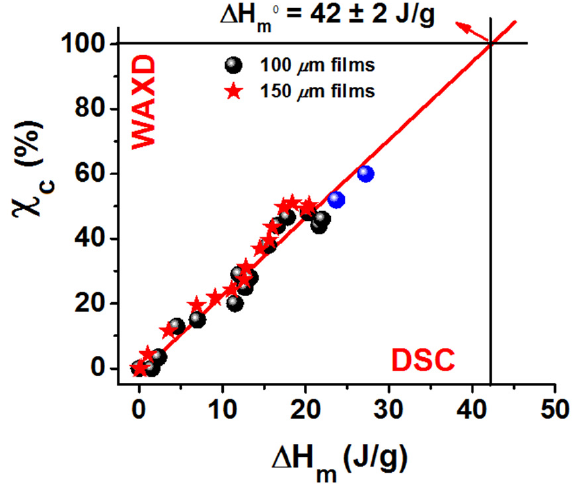
Figure 7. Crystallinity index ( χ c , from WAXD patterns) and melting enthalpy ( ∆ H m , from DSC scans) of NC α form films, obtained by BE guest-induced crystallization of amorphous PPO films of different thickness: ( • ) 100 µ m; ( (cid:70) ) 150 µ m. The blue circles indicate 100 µ m films as crystallized after 2800 min immersion in BE and subsequently annealed at 40 ◦ C and 60 ◦ C. The red line indicated the extrapolation to a fully crystalline α -form PPO sample.